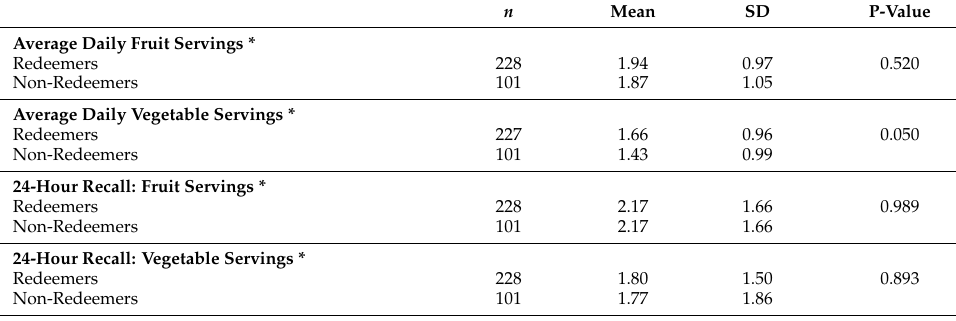
Table 2. Fruit and Vegetable